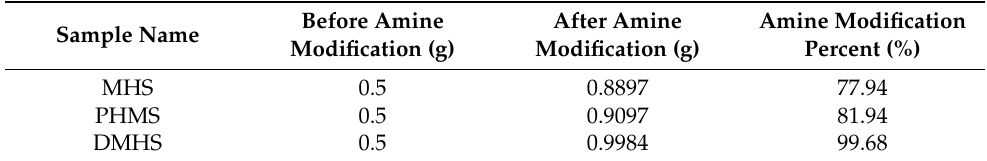
Table 3. Amine modification percentage of MHS, PHMS, and DMHS.